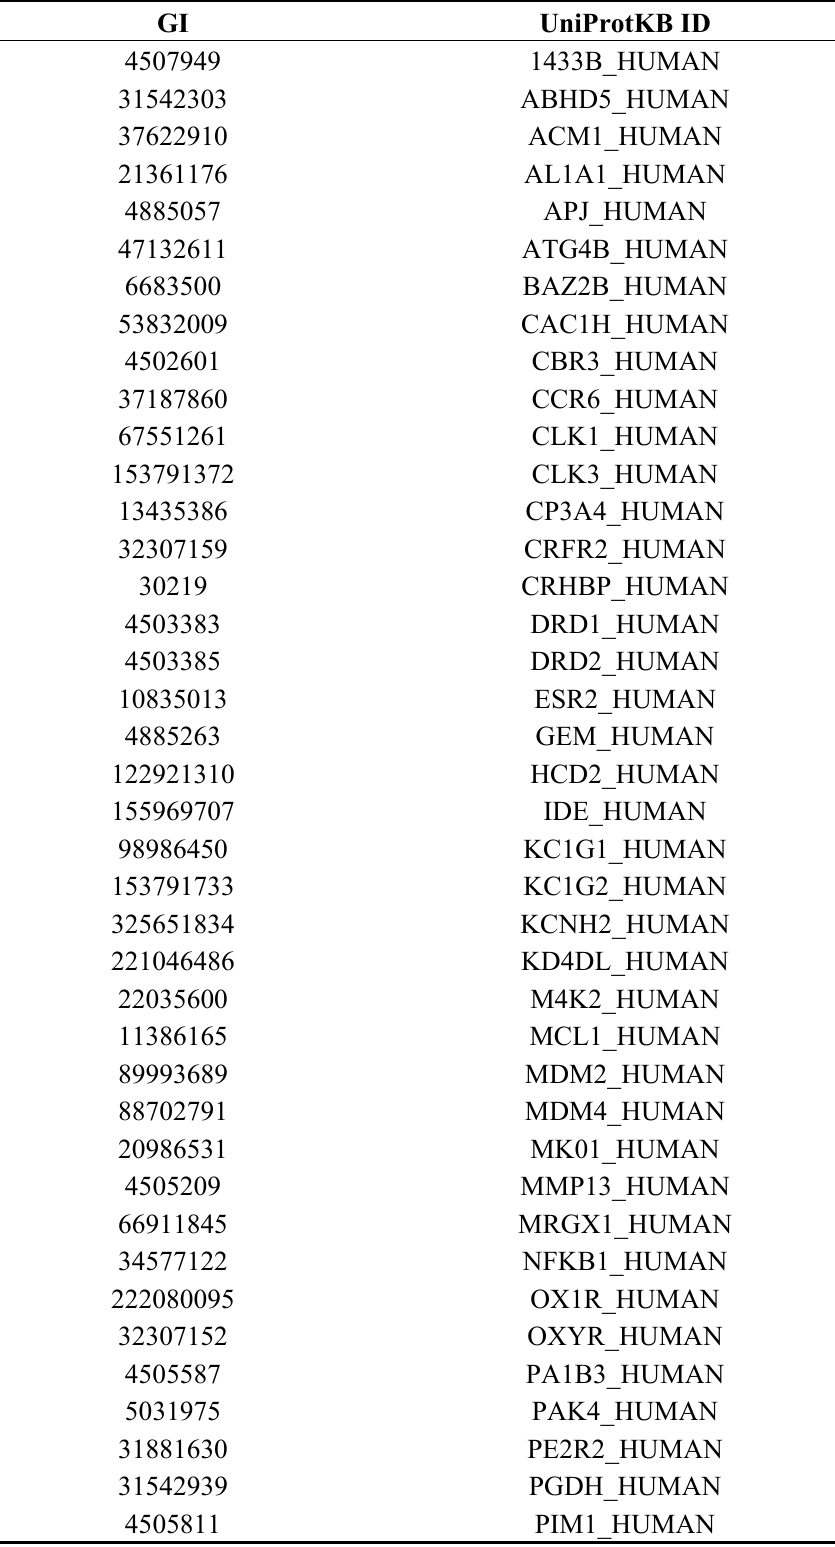
Table 2. Human target proteins of curcumin in PubChem.